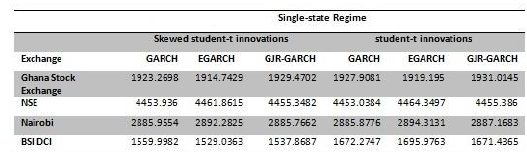
Table 5: DICs for Single-State Regime Switching GARCH Models